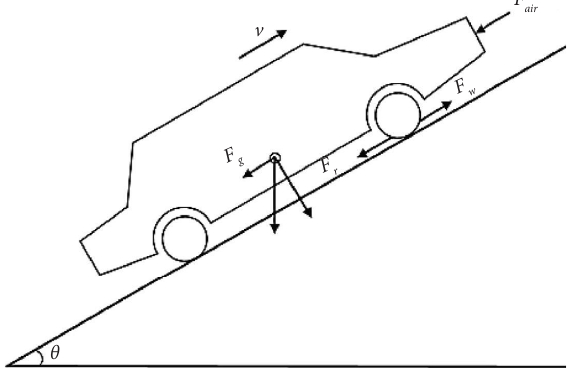
Figure 1: Longitudinal forces acting on the car.